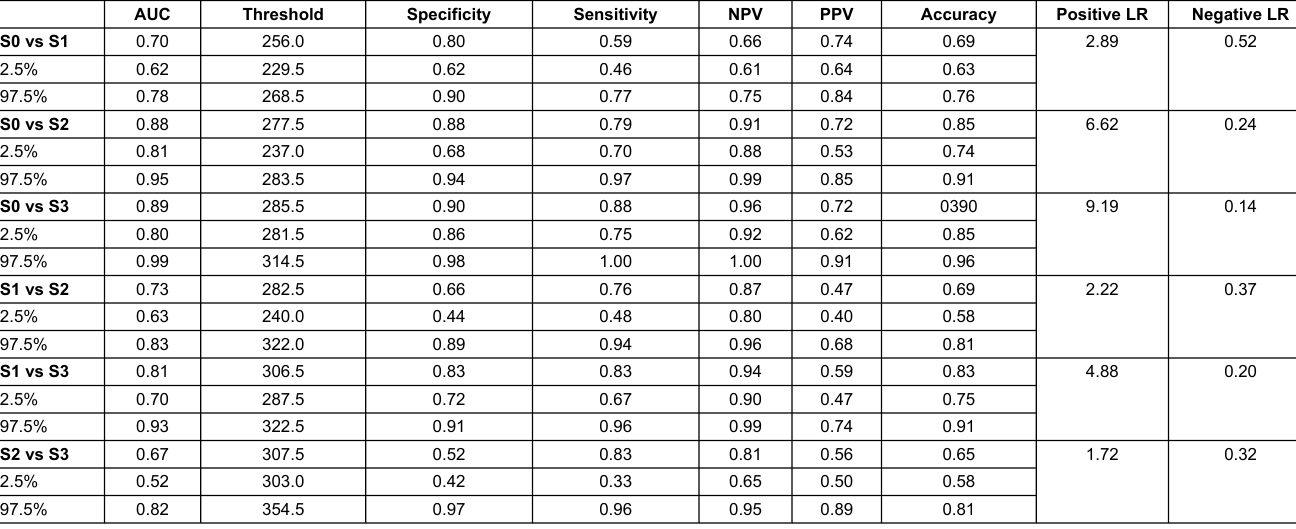
AUC Threshold Specificity Sensitivity NPV PPV Accuracy Positive LR Negative